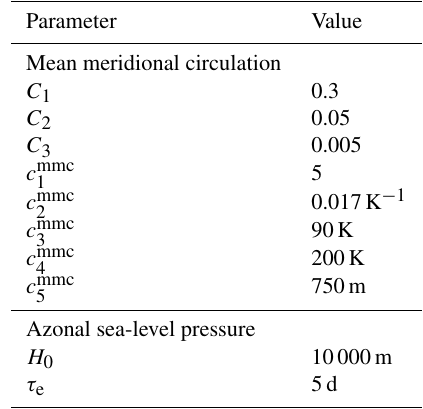
Table A2. Parameters for atmospheric